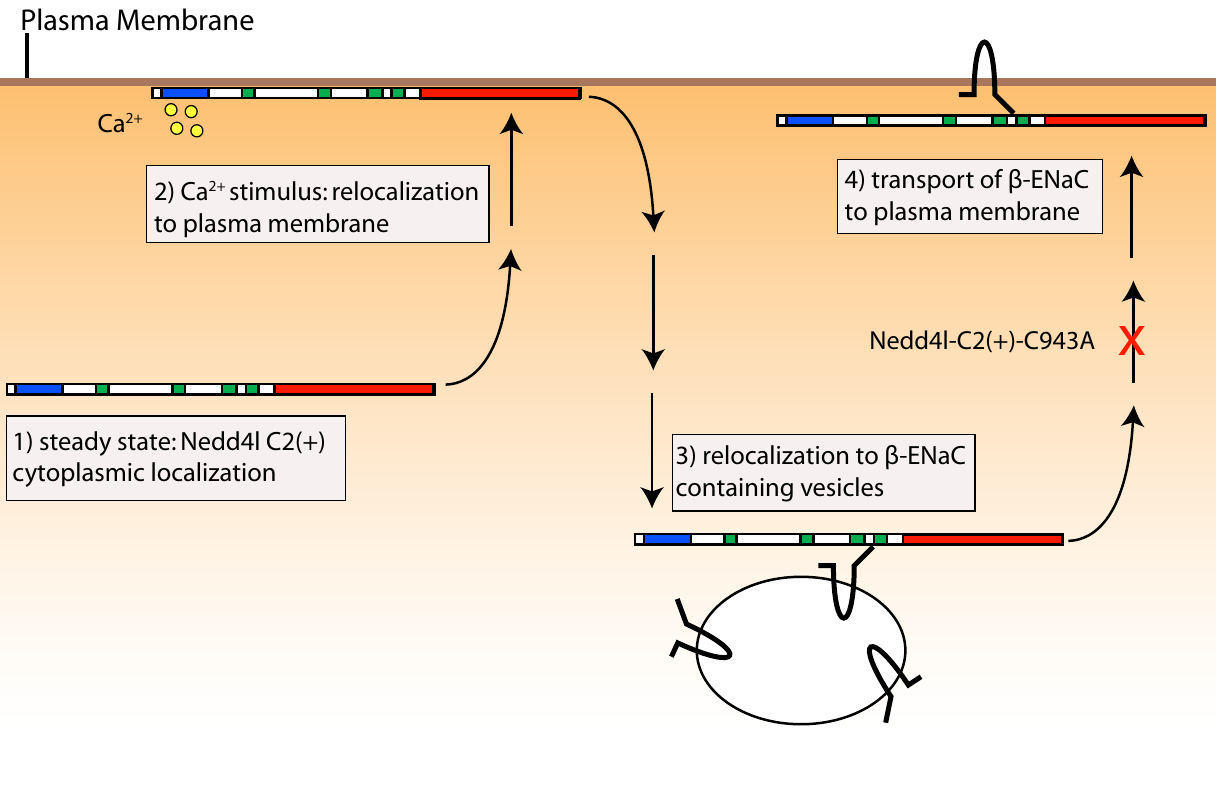
Figure 6 Summary schematic of the observed mobilization response of NEDD4L-C2(+) in response to a Ca 2+ stimulus . NEDD4L-C2(+)-C943A that lacks ubiquitin ligase activity does not mobilize to the plasma membrane in step 4, and prevents β